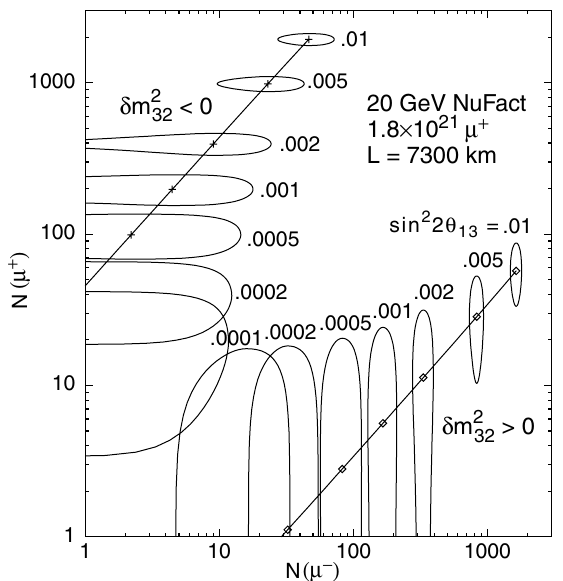
(cid:4) 10 (cid:1) 4 eV 2 , and (cid:6) (cid:4) 0 . 21 ; sin 2 2 (cid:5) varies along 13 32